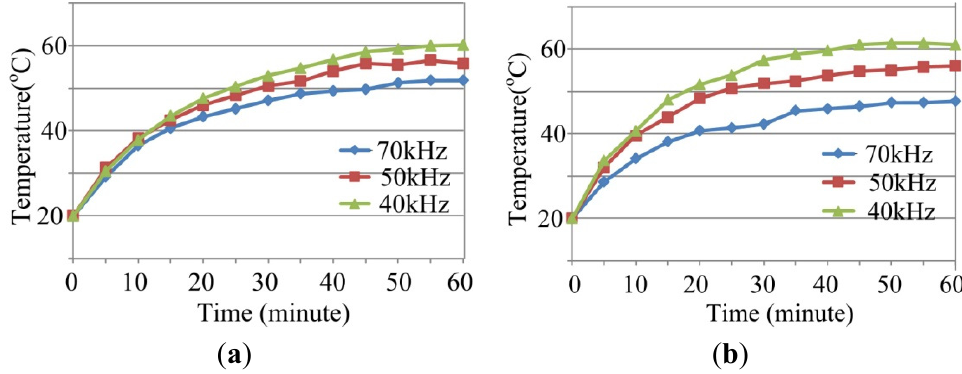
Figure 6. Temperatures of magnetic components with different switching frequencies ( a ) Temperature of transformer; ( b ) Temperature of filter inductor.